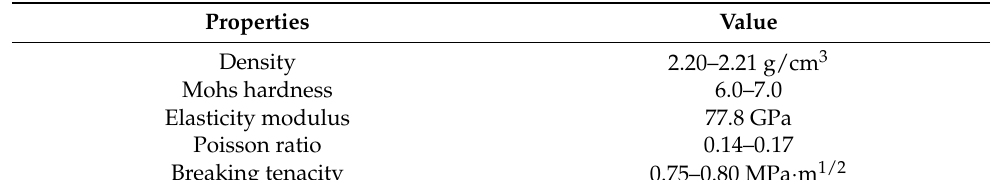
Figure 1. Composition of W7 diamond FAP. Table 1. Physical and mechanical properties of quartz glass.